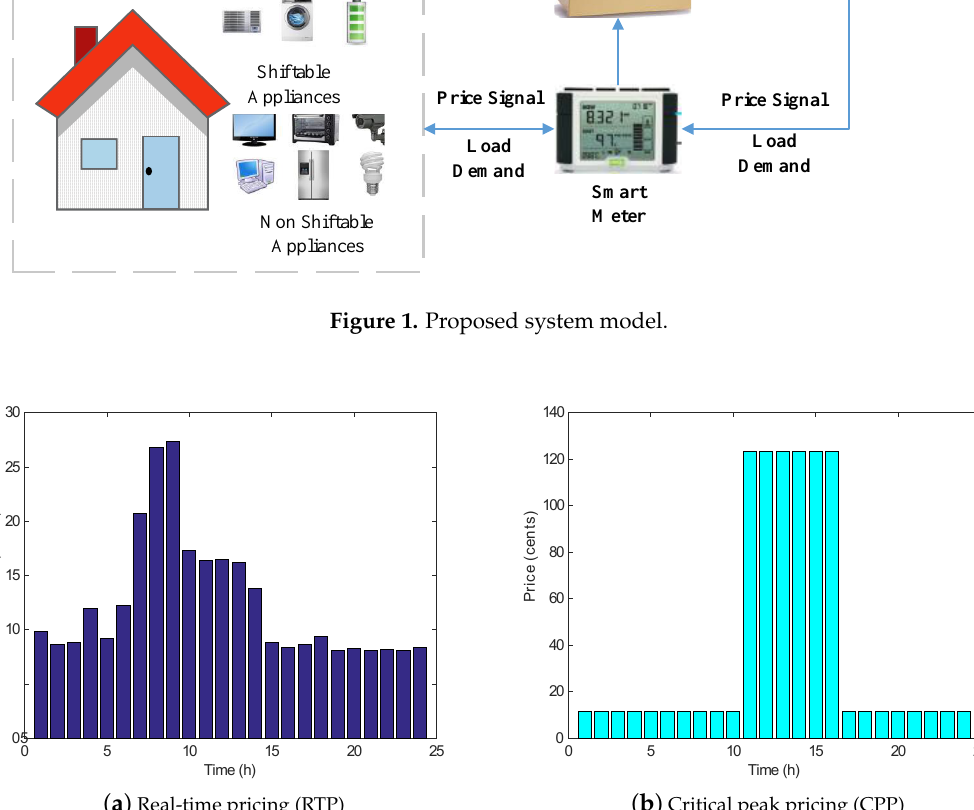
Figure 2. Pricing